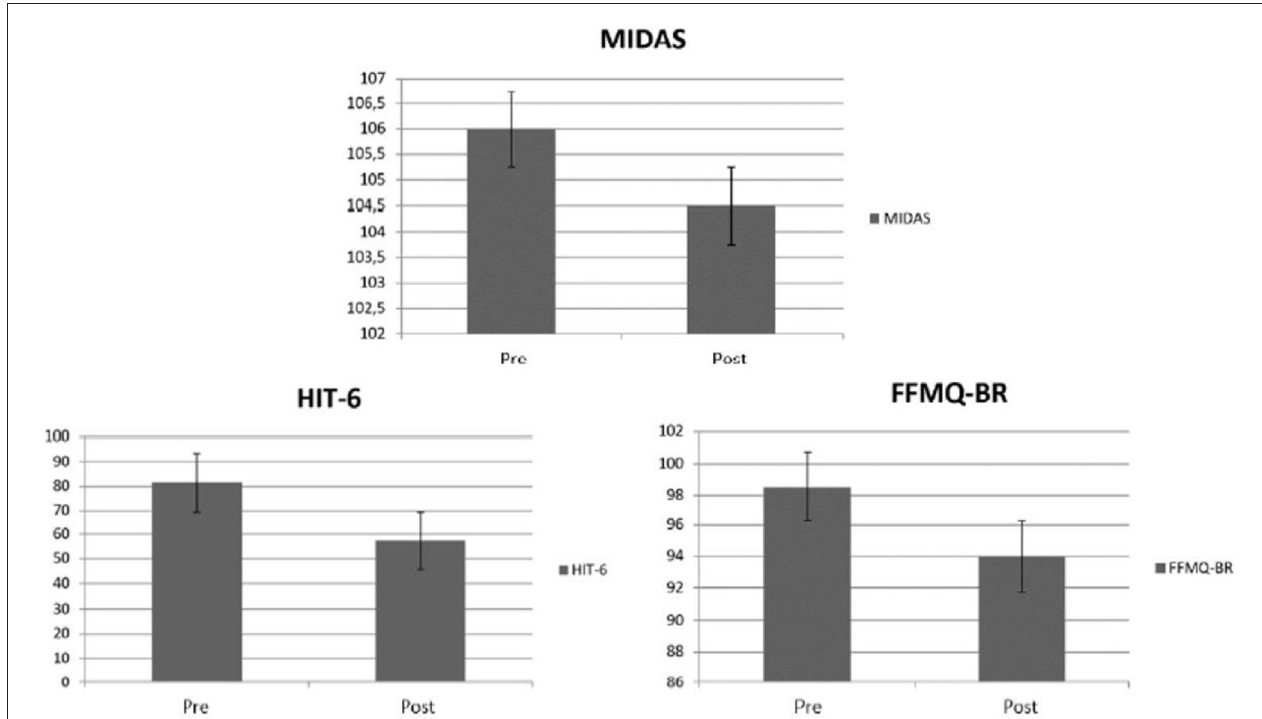
FIGURE 5 | Bar graphs representing the Man-Whitney Test scores ± standard error of the three clinical outcomes at baseline and endpoint of active and sham conditions. Questionnaires scores, respectively, MIDAS, HIT-6, and